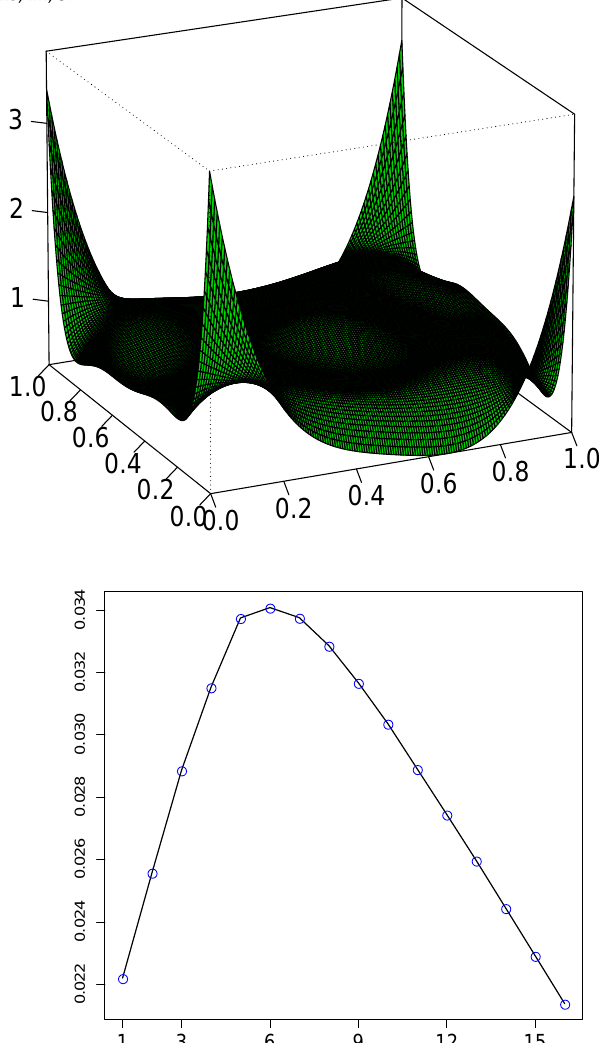
Figure 3. Top : Nonparametric smooth serial copula density (lag one) estimate of S&P return data. Bottom : BIC plot to select the significant LP-comoments computed in Equation